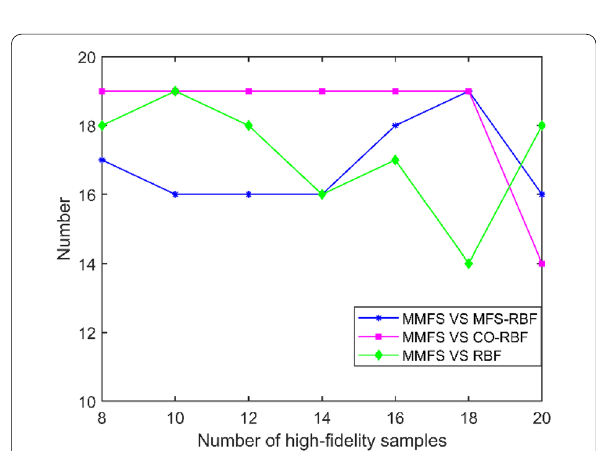
Figure 10 Number of MMFS better than other methods of 20 DoEs of Goldpr